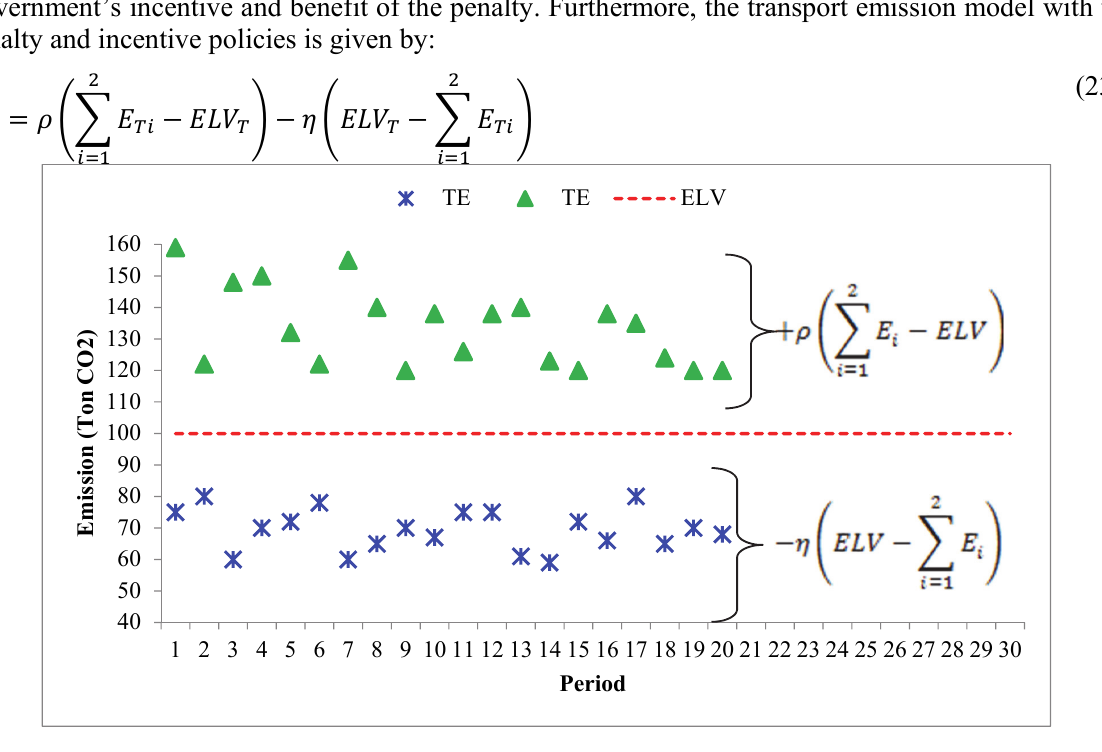
Fig. 3. The illustrated of penalty and incentive